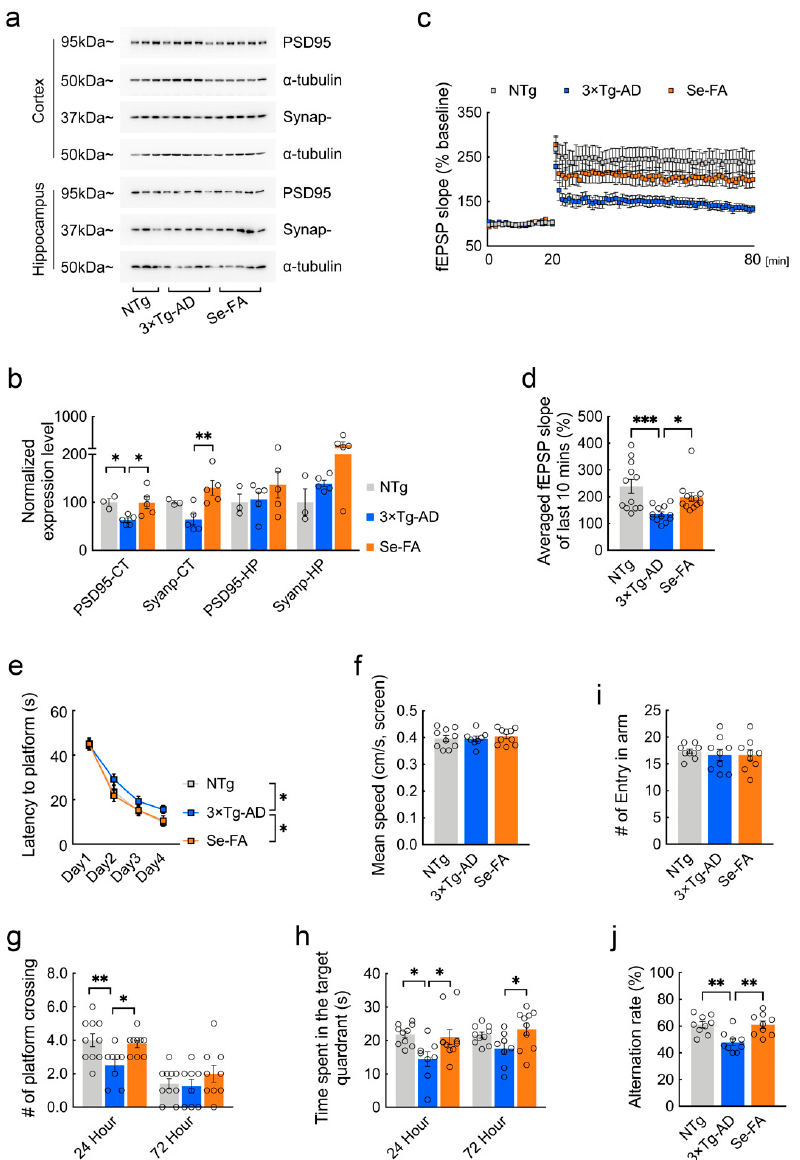
Figure 6. Se-FA restores synaptic plasticity and improves cognitive ability in 3xTg-AD mice. ( a ) Levels of PSD95 and synaptophysin were analyzed by immunoblot in the cortex and hippocampus of mice. α -Tubulin was used as a loading control. ( b ) Quantitation of the protein levels in ( a ) (n = 3 or 5 mice). ( c ) Slope of fEPSPs in response to 100-Hz stimulation in the Schaffer collateral CA1 region of the mice. ( d ) Quantification of the averaged fEPSP slope of the last 10 min in ( c ) (n = 12 sections, 3 sections per mouse). ( e – h ) Morris water maze tests were performed in 7-month-old 3×Tg-AD mice (two-way ANOVA followed by Dunnett’s multiple comparison test) (n = 8 or 10 mice). The escape latency time to reach the hidden platform was recorded during the 4-day training ( e ). Swimming speed was recorded during the probe trial ( f ). The probe trial was performed 24 and 72 h after the last trial of a hidden platform task. The number of crossings over the original platform area was recorded ( g ), along with the percentage of search time spent in each quadrant ( h ). ( i , j ) The number of arm entries ( i ) and number of correct alternations ( j ) in the Y maze test (n = 9 mice). All the mice were fed diets with Se-FA or a control diet for 12 weeks. All data are presented as the mean ± SEM. * p < 0.05, ** p < 0.01, *** p < 0.001 as determined by one-way or two-way ANOVA followed by Dunnett’s multiple comparison